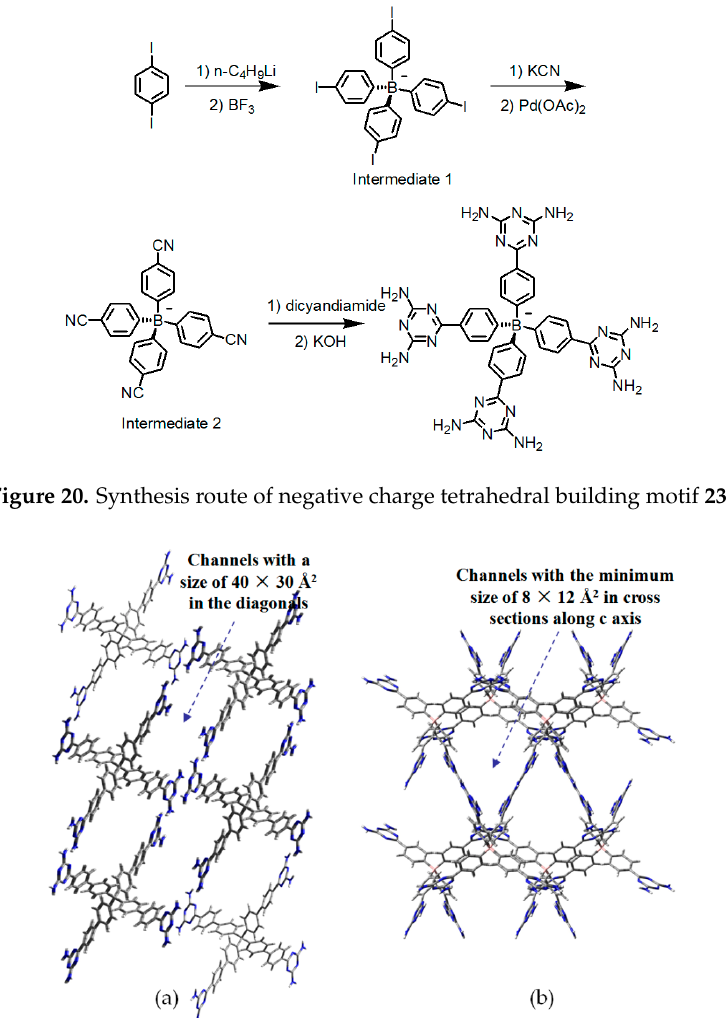
Figure 21. Crystalline porous network of H21 ( a ) and H23 ( b ).